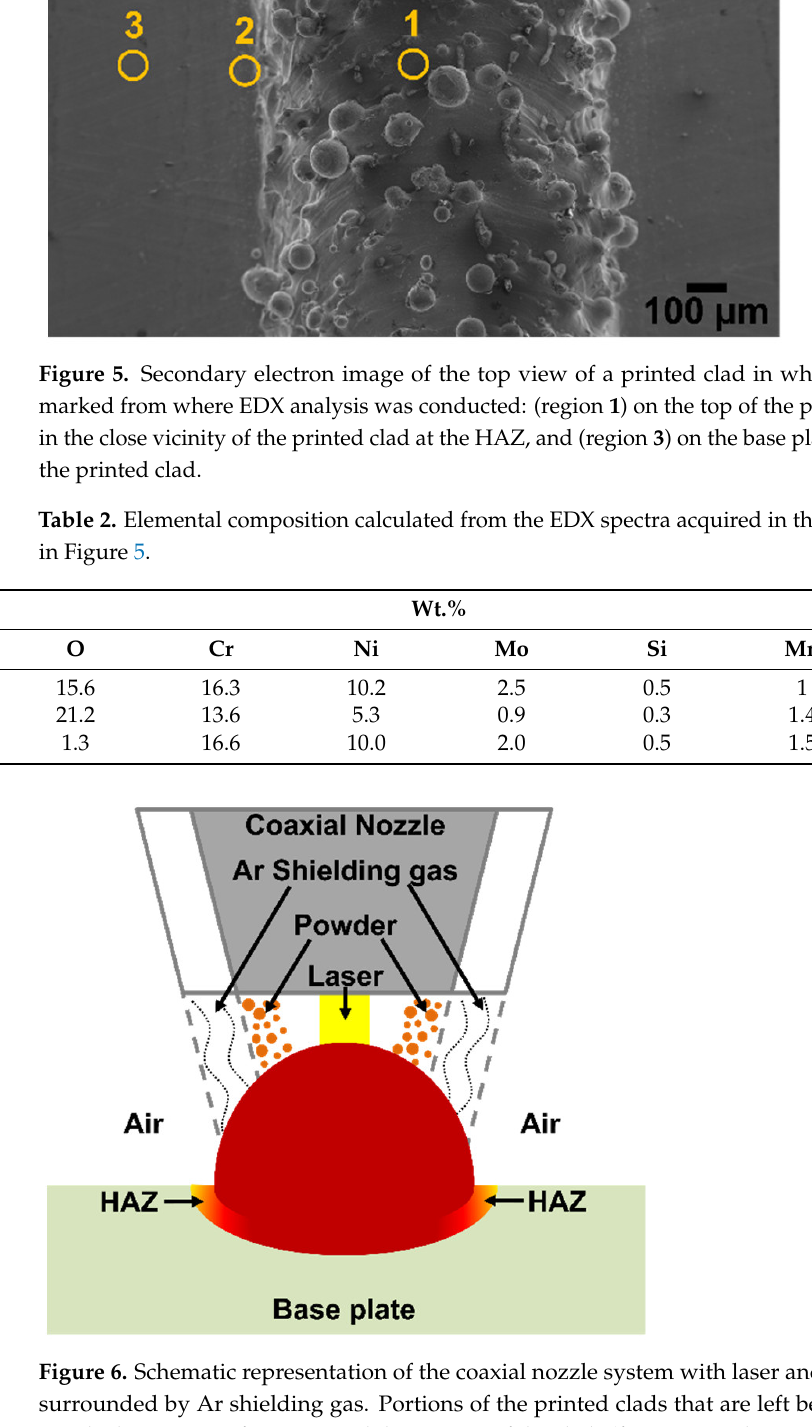
Figure 6. Schematic representation of the coaxial nozzle system with laser and powder flow being surrounded by Ar shielding gas. Portions of the printed clads that are left behind by the moving nozzle during manufacturing and the vicinity of the clads (for instance the HAZ region) are exposed to ambient air while still at elevated temperatures. The high content of thermal oxides formed during the DED manufacturing process on the HAZ and on the surface of the printed clads can be the source of the high amount of oxide inclusions often found in multi-layered DED 316L SS [10,30,44,45]. While no in- clusions could be found on the deposited single clads analysed, this was not the case when several layers of the material were deposited by DED. Figure 7 shows micrographs of regions in DED printed parts made up of several layers in which numerous manganese silicate inclusions can be observed (as measured with EDX analysis). The schematic of Figure 8 graphically represents the formation of oxide inclusions from the thermal oxides formed on the HAZ and on the surface of the printed clads when multiple overlapping clads are deposited by DED. These oxide inclusions can greatly affect the corrosion